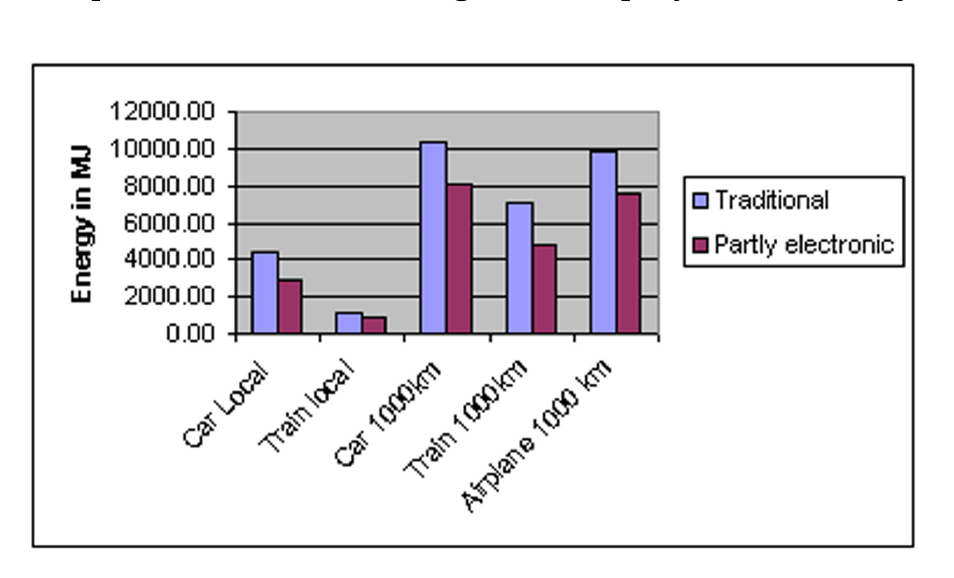
Figure 8: Comparison of energy consumption of traditional and partial electronic auditing for a company 1000 km away